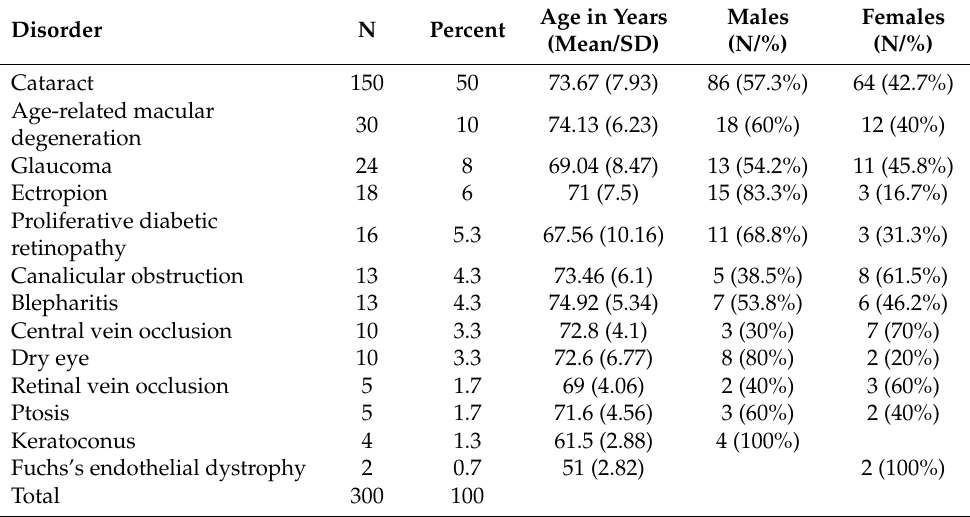
Table 1. Underlying